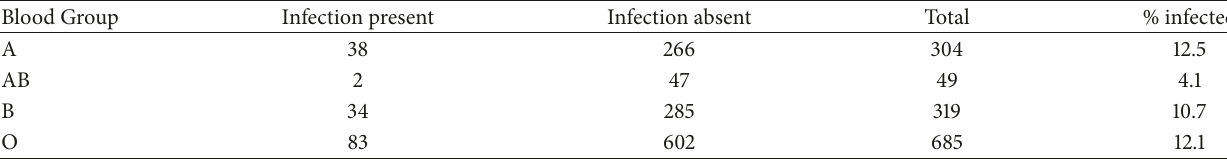
Table 1: Distribution of Plasmodial infections by blood type.